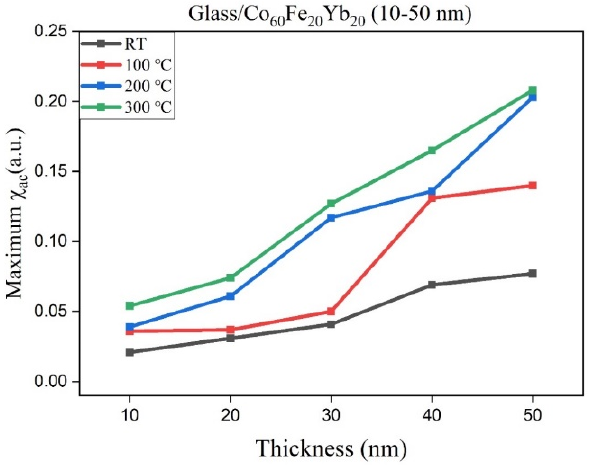
Figure 3. Maximum χ ac for the CoFeYb thin films. Table 2. The optimal resonant frequency for various thicknesses.